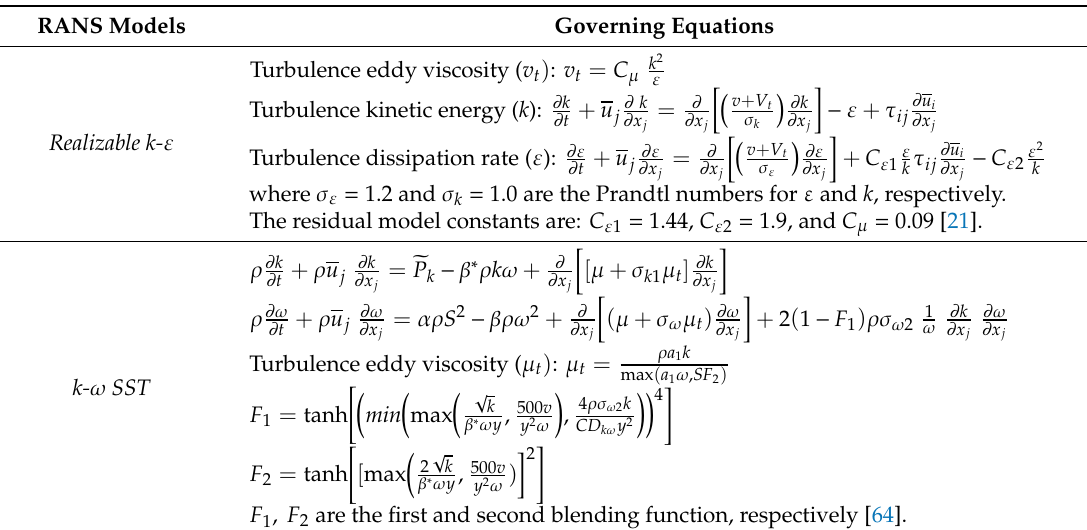
Table A1. Governing equations of RANS